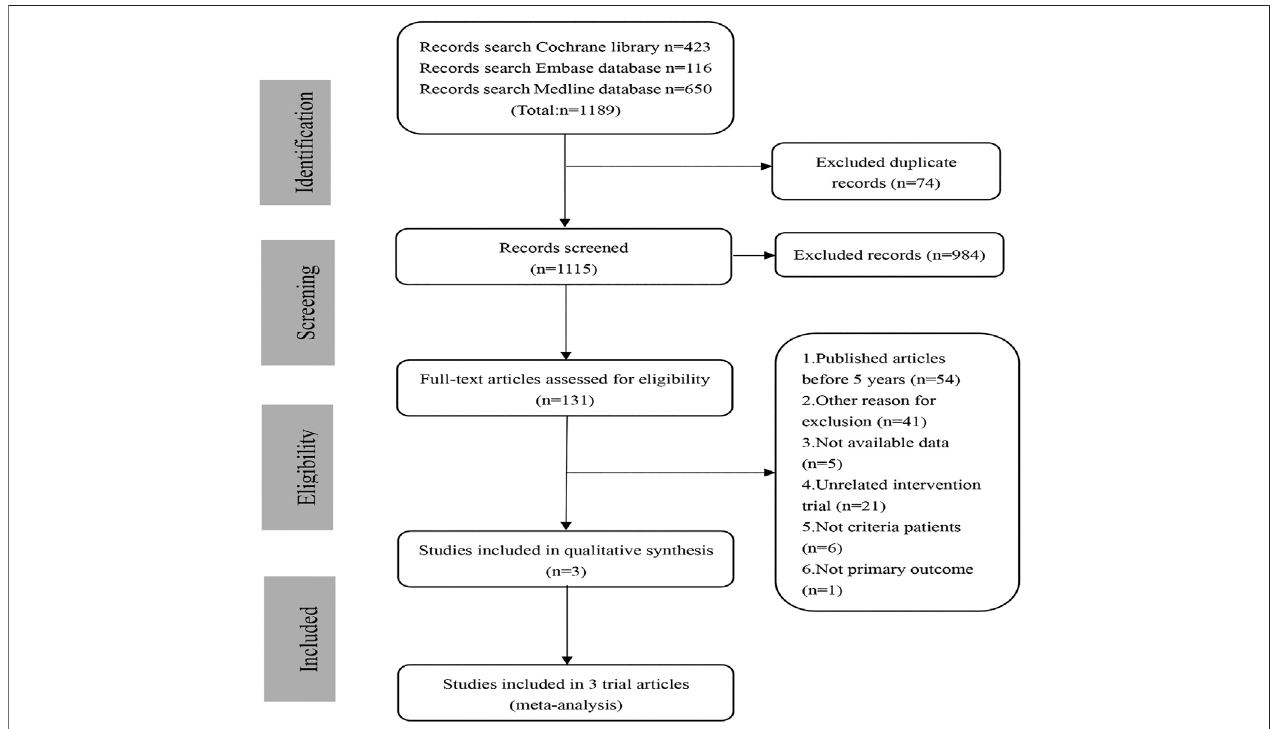
FIGURE 1 | Flowchart for data